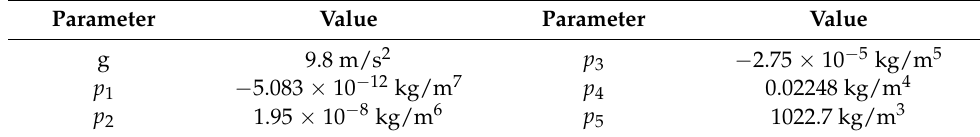
Table A4. Environmental